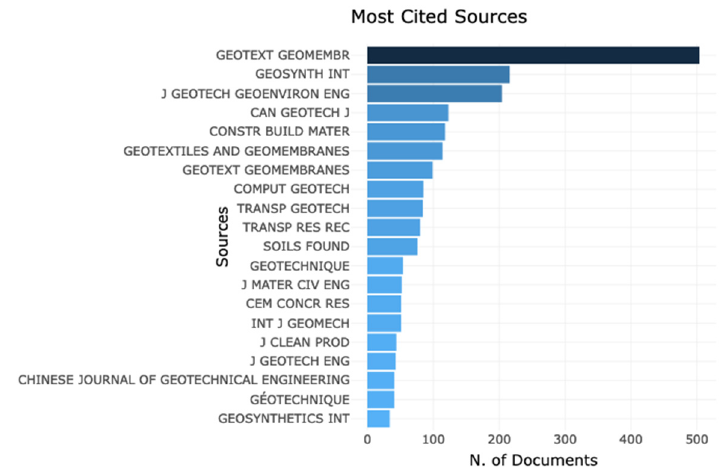
Figure 13. Most locally cited sources. Table 8. Sources’ local